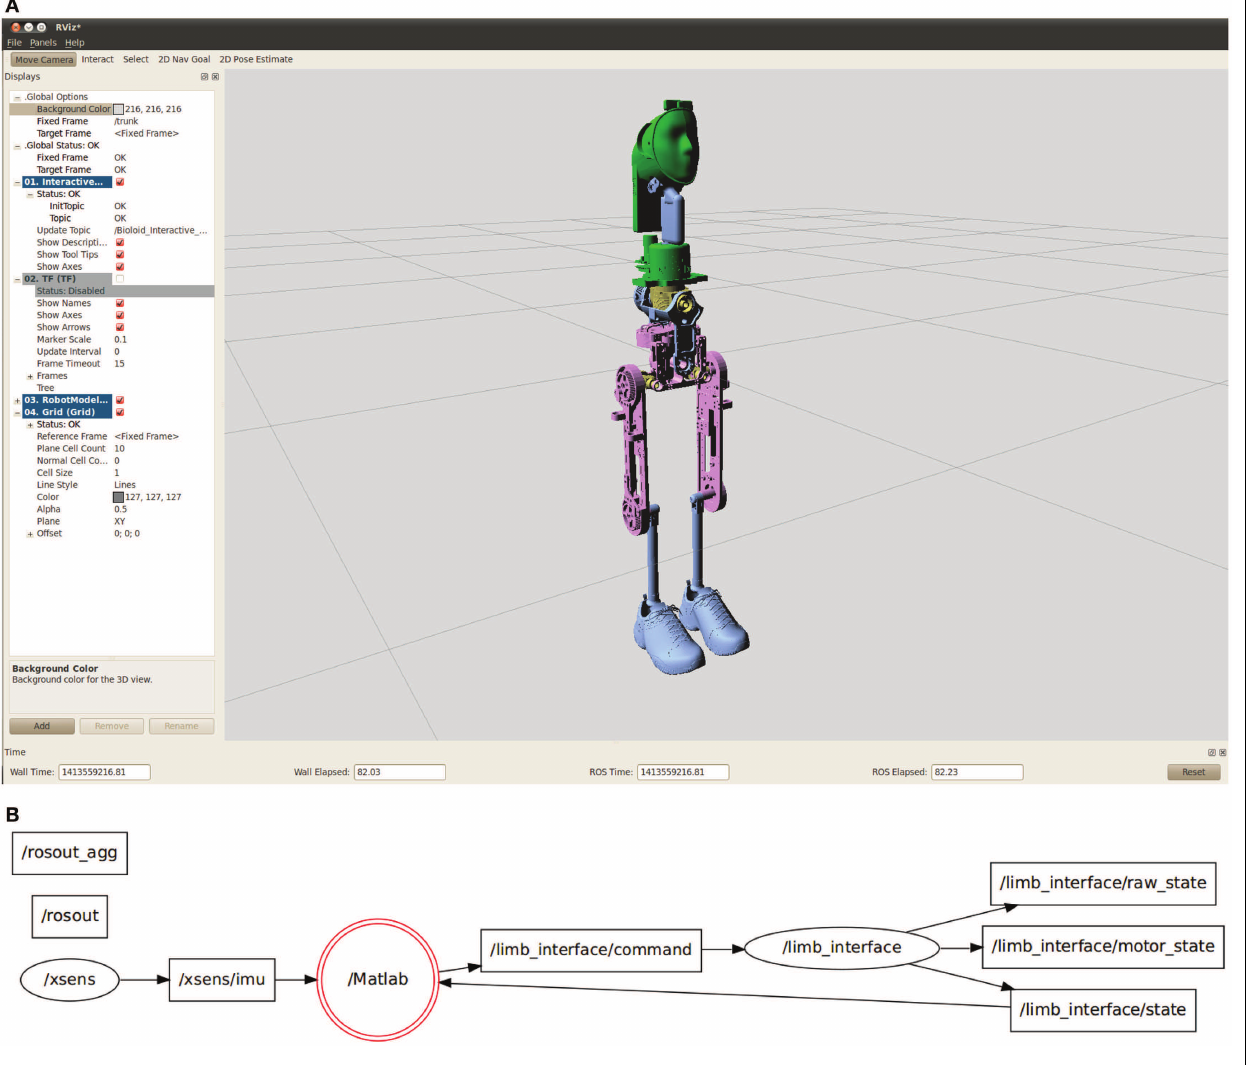
FIGURE 10 | (A) Screenshot of Herbert in Rviz. (B) Overview of the ROS nodes captured from